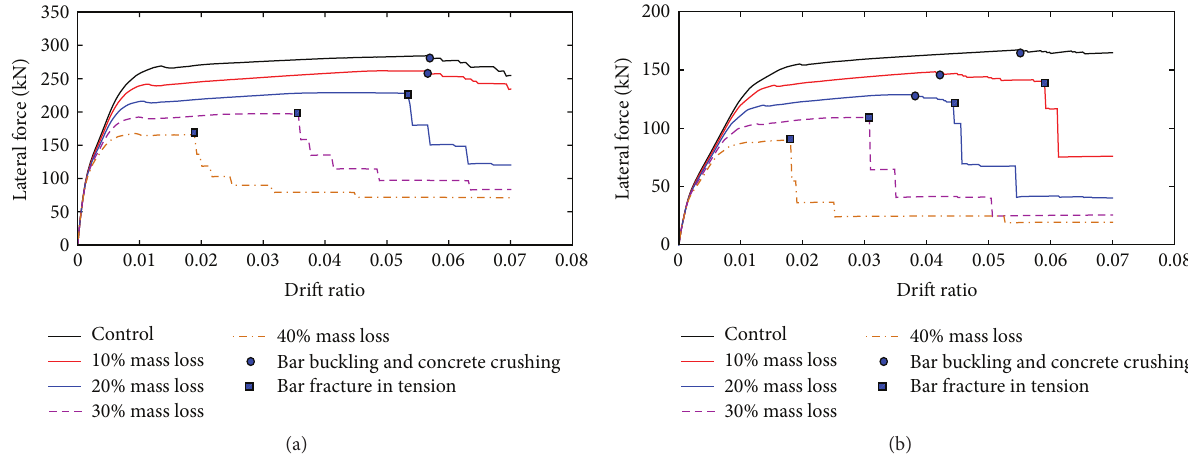
Figure 9: Pushover analyses considering corrosion induced damage in reinforcing steel: (a) Lehman’s column 415; (b) Moyer and Kowalsky’s column